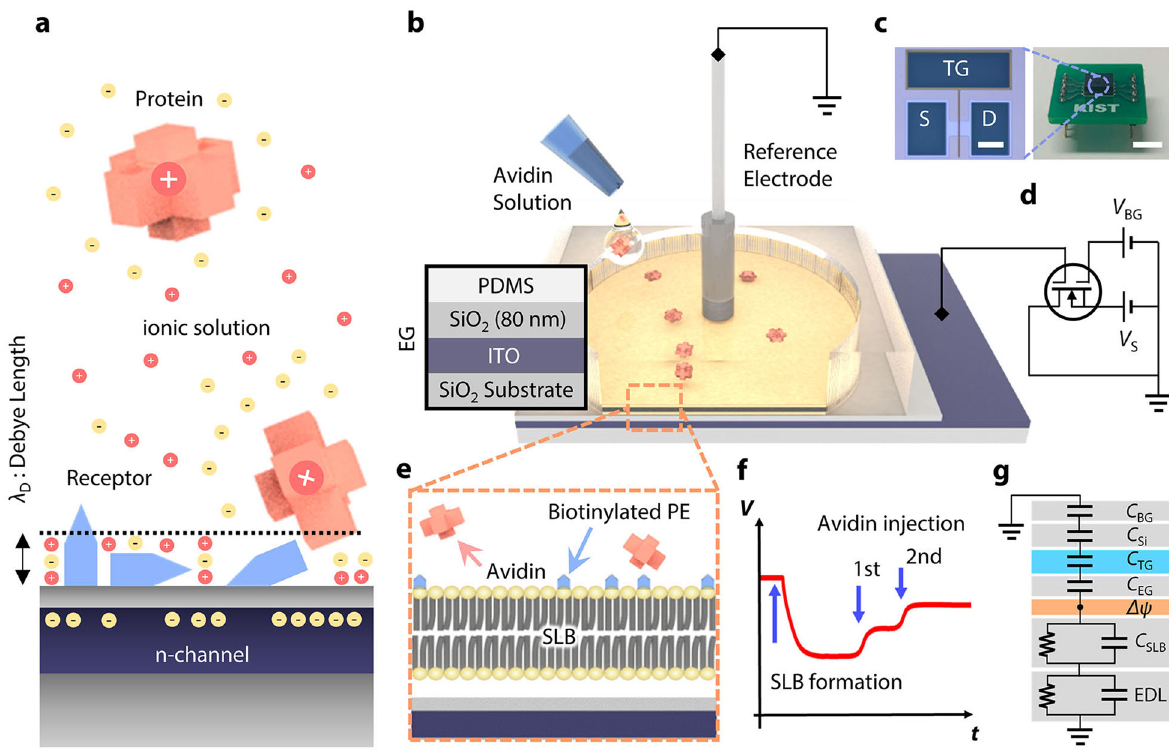
Fig. 1 Electrical sensing in ionic environments and schematic of the SLB-assisted FET measurement setup. a Challenges to potentiometric measurement schemes for molecular detection on an FET under ionic environment: formation of the EDL, non-speci fi c binding, and randomly oriented receptors. b Schematic representation of a reaction chamber on the EG. (left) Layer-by-layer con fi guration of the EG. Polydimethylsiloxane (PDMS) chamber acts as a reaction chamber. c Optical images of the FET (left) and a packaged device (right) (scale bars = 100 μ m and 5 mm, respectively). d Schematic representation of measurement setup. e Cross-sectional illustration of the SLB on the EG surface. f Proof-of-concept for real-time detection during biotin – avidin binding. g Equivalent circuit model for the measurement